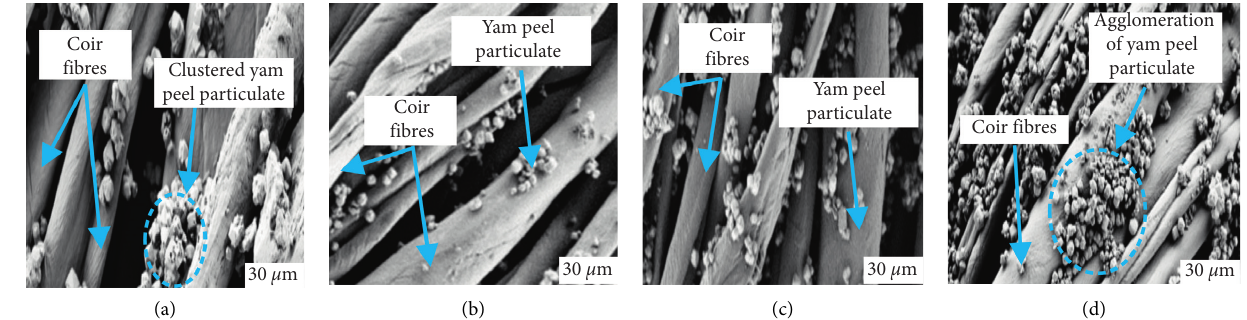
Figure 6: Morphology of (a) 2 wt.% CF/YPP, (b) 4 wt.% CF/YPP, (c) 6 wt.% CF/YPP, and (d) 8 wt.% CF/YPP samples at the reinforcement- matrix interface.